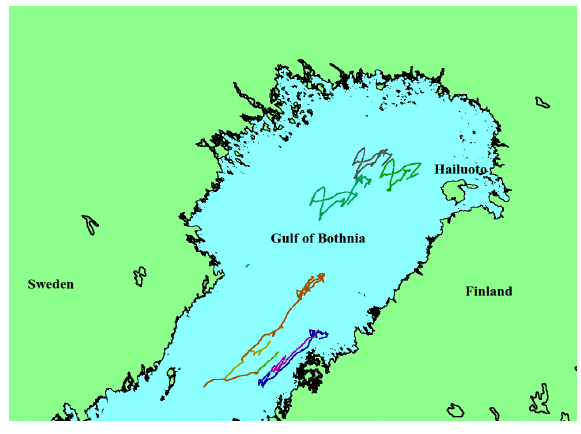
Fig. 7. Buoy tracks shown with different colors for each buoy.